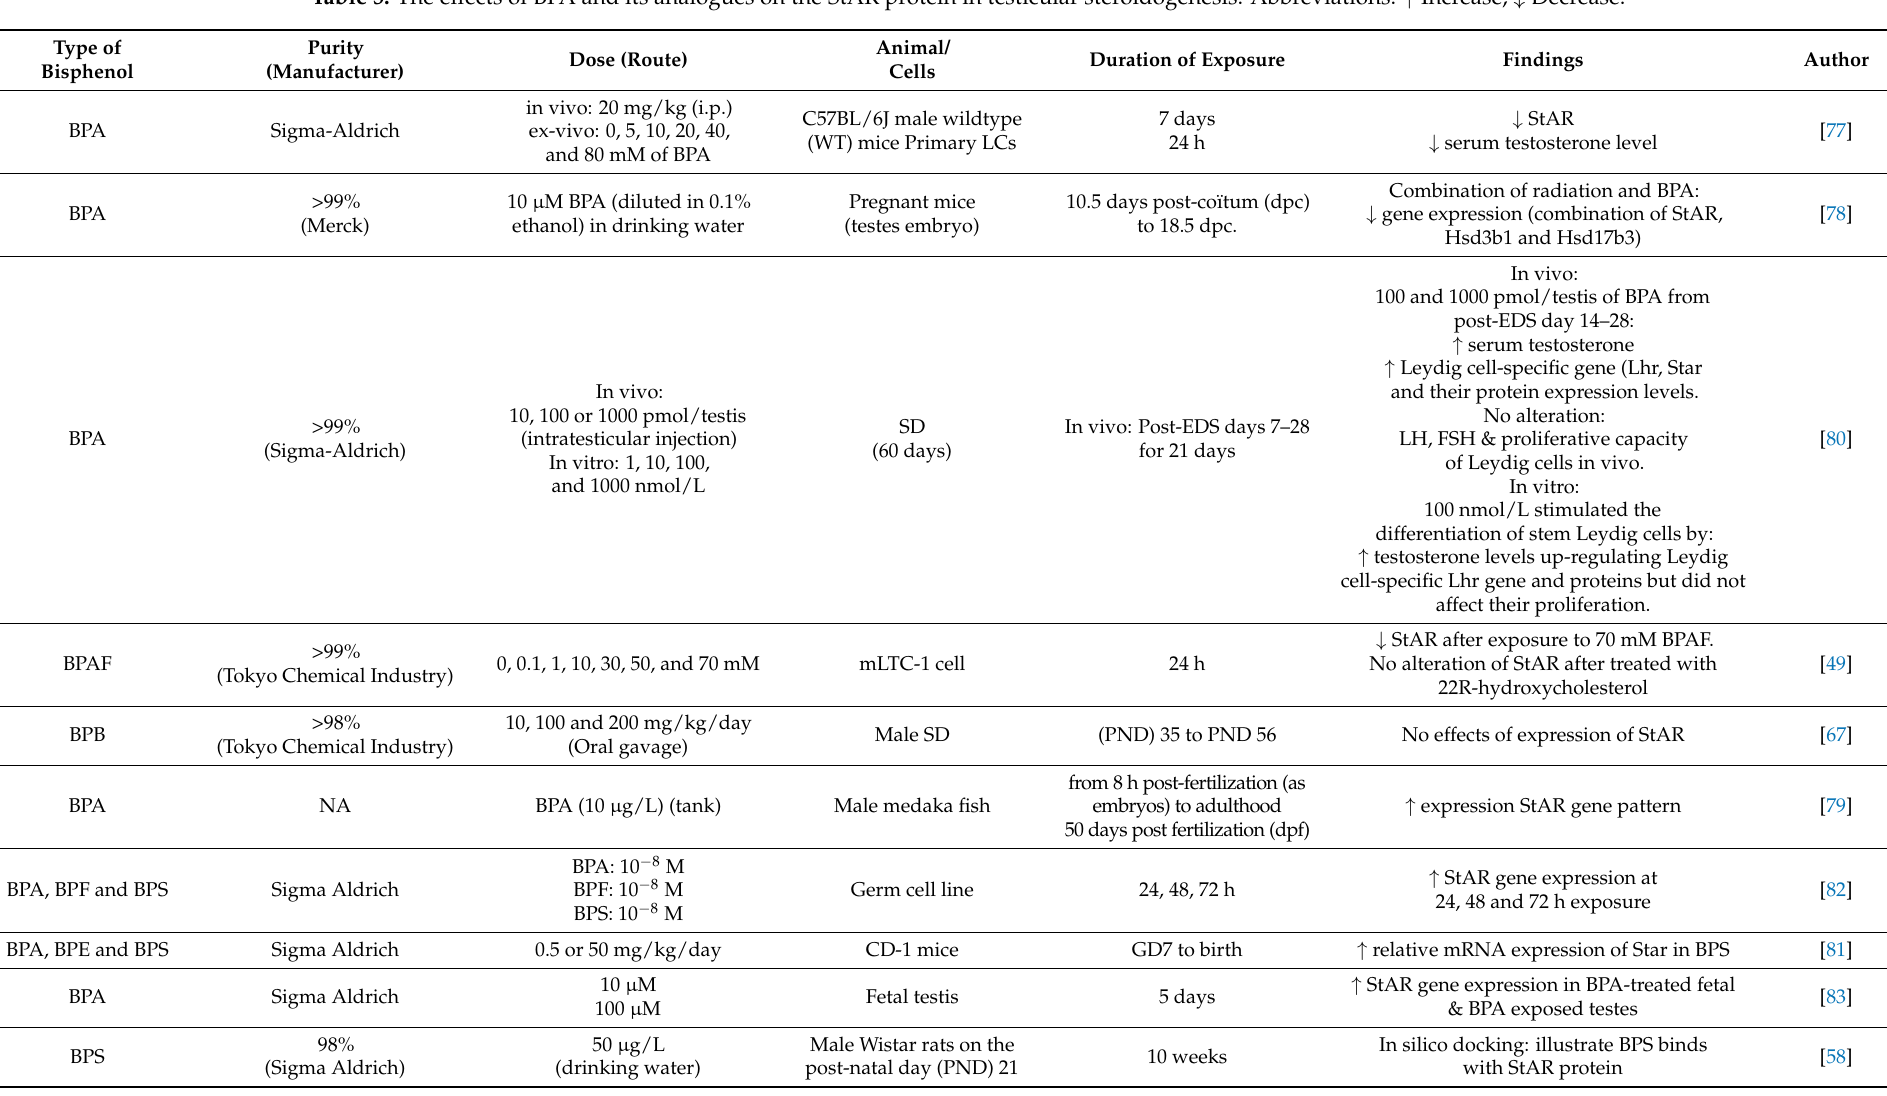
Table 5. The effects of BPA and its analogues on the StAR protein in testicular steroidogenesis. Abbreviations: ↑ Increase; ↓